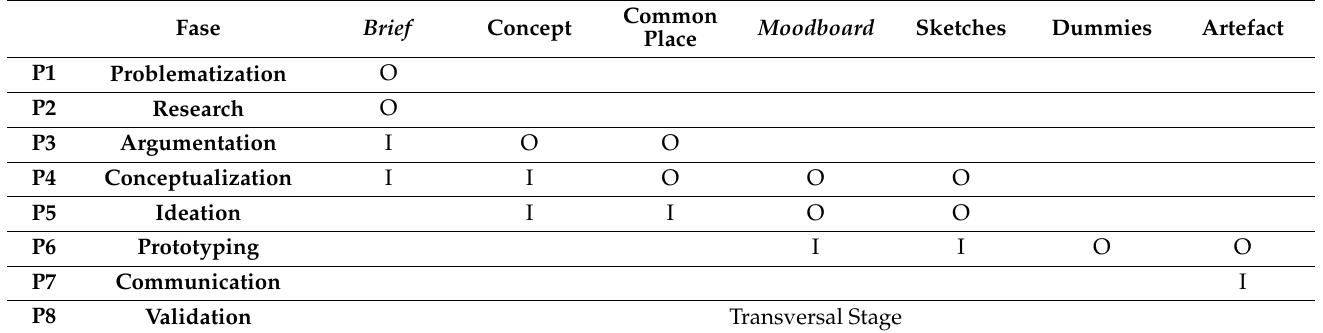
Table 4. Relationship between the phases of the design method and the input and output artifacts (own